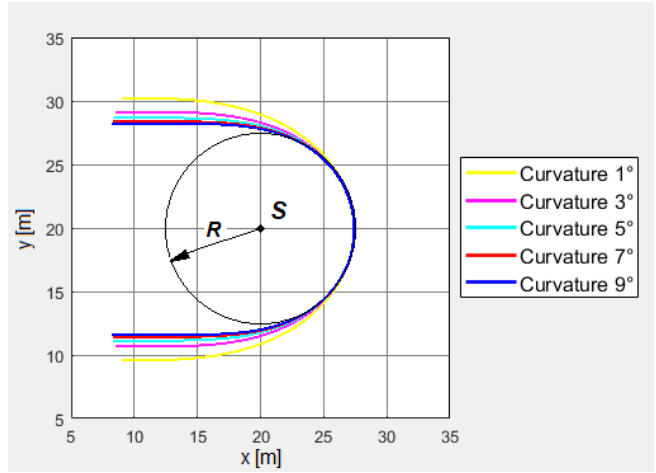
Figure 7. The “half of chi” (HoC) motion trajectories for the bi-curves whose curvature is described by the linear function as well as the third, fifth, seventh, and ninth degree polynomials.